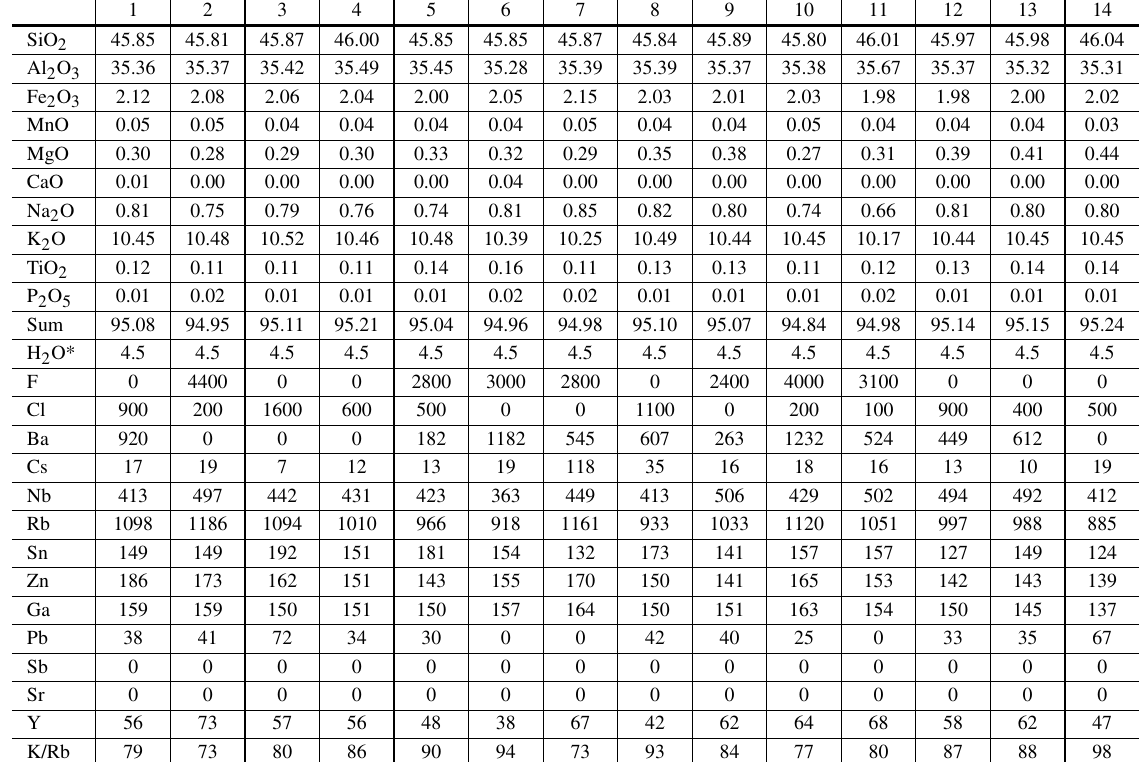
Chemical analyzed of large muscovite from Cruzeiro Pegmatite (oxides in % Wt and ions in